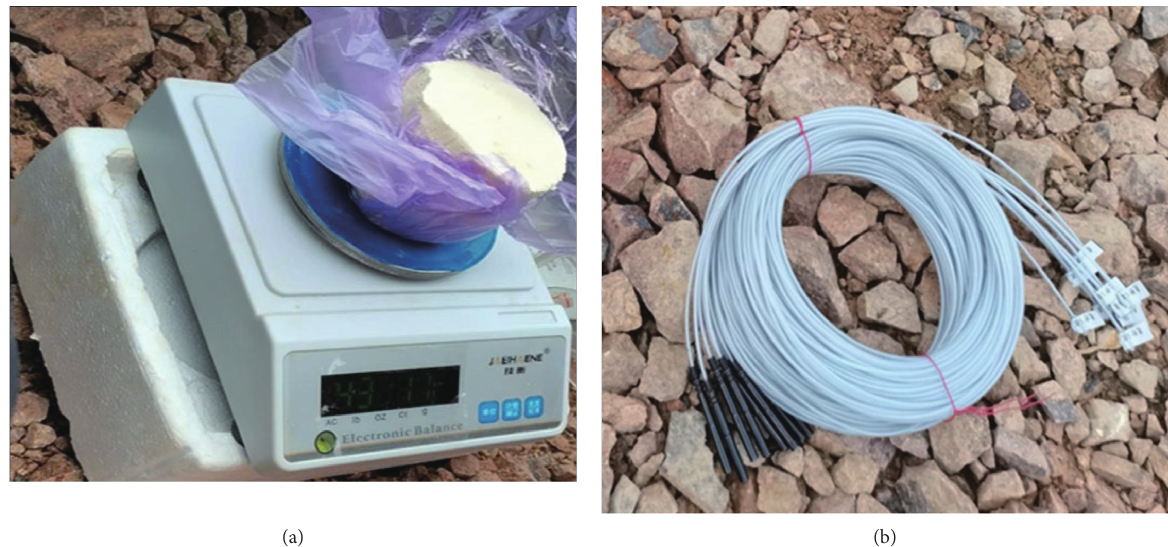
Figure 3: Explosive charge and detonator. (a) Rock emulsion explosive. (b) Detonator.